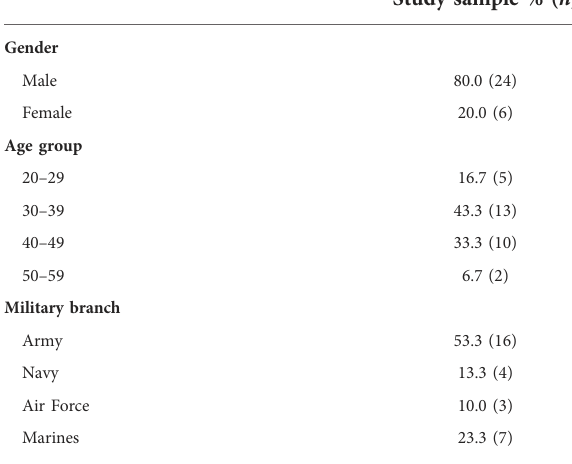
TABLE 1 List of sociodemographic factors of study